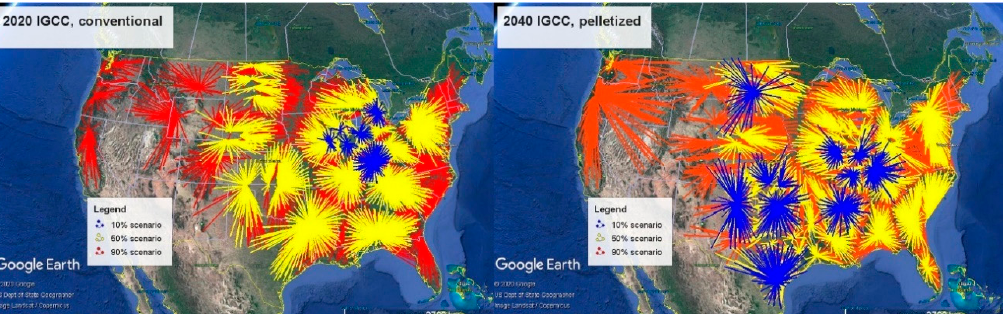
Figure 5. Delivered biomass feedstock quantities (exajoules) and costs ($ per gigajoule) modeled in the four scenarios and nine CO 2 capture levels.